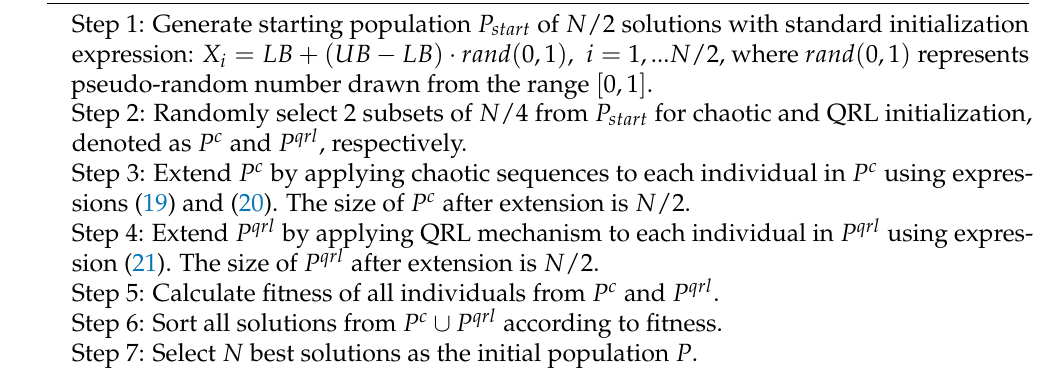
Algorithm 1 Pseudo-code for chaotic and QRL population initialization.